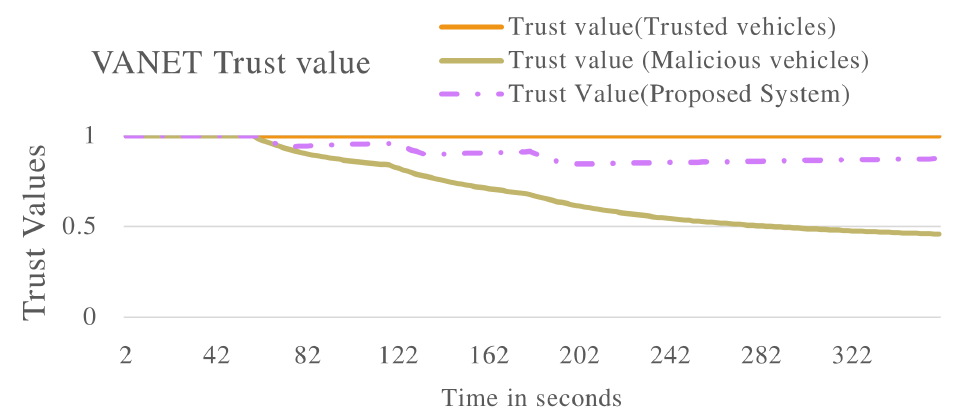
Figure 8. VANET trust value multiple scenarios including vehicles that are delaying packets in the